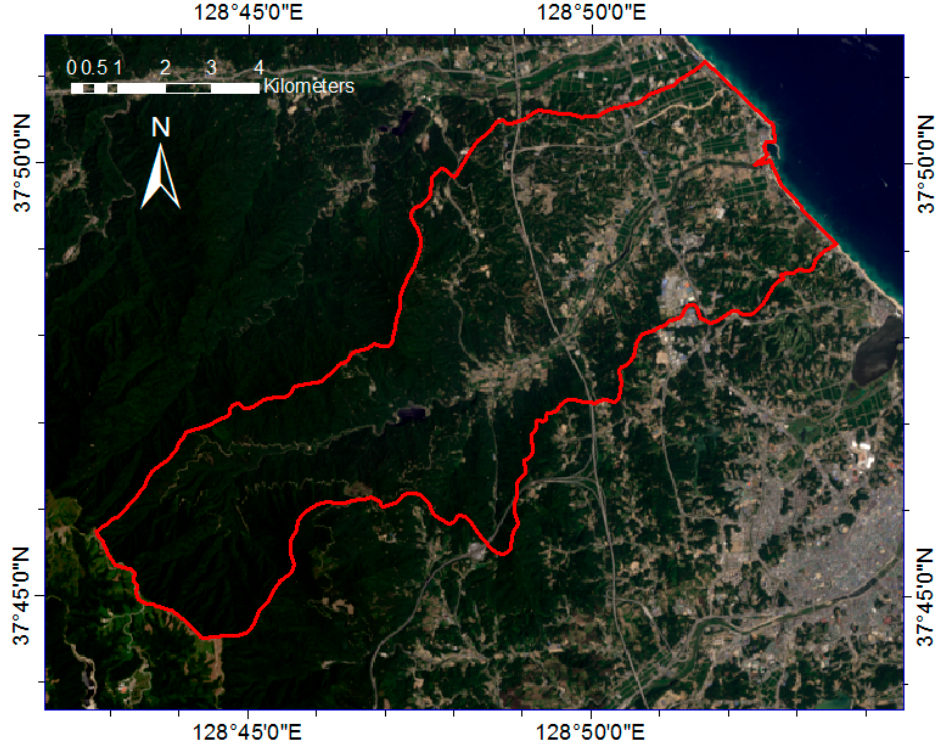
Figure 1. Location of the study area from Landsat Imagery, acquired on 21 July 2018 [40].